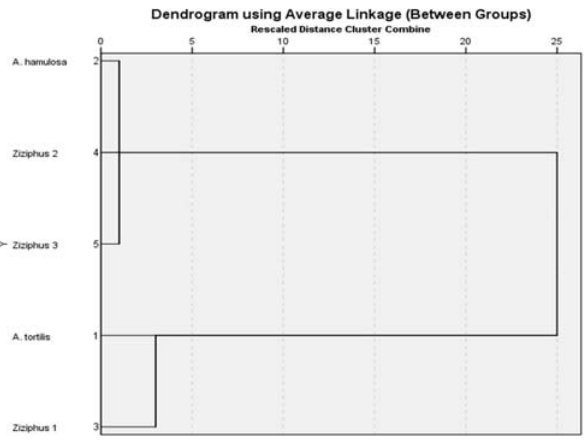
Figure 2: The agglomerative hierarchical clustering of the studied honey samples. The honey samples were clustered according to the values of their quality parameters and protein